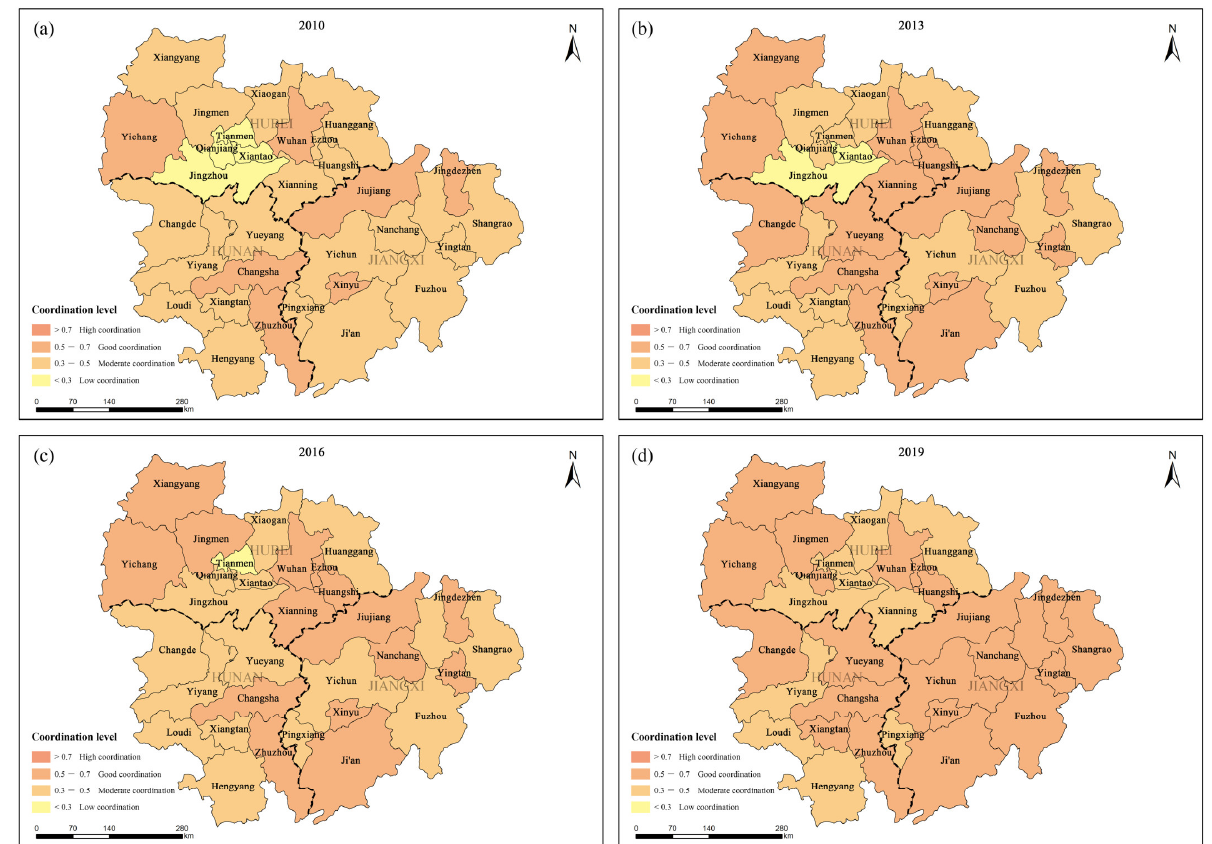
Figure 8. Spatial distribution of coupling coordination level of 31 cities in: ( a ) 2010; ( b ) 2013; ( c ) 2016; ( d ) 2019.